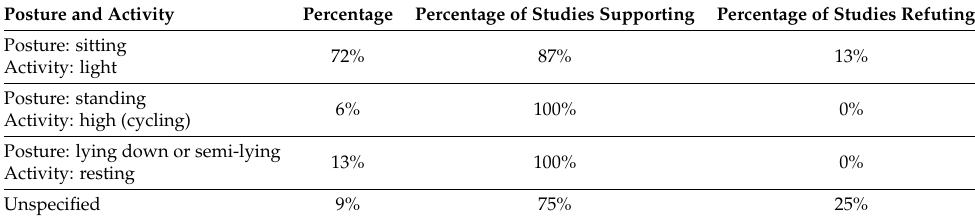
Table 6. Influence of posture and activity.